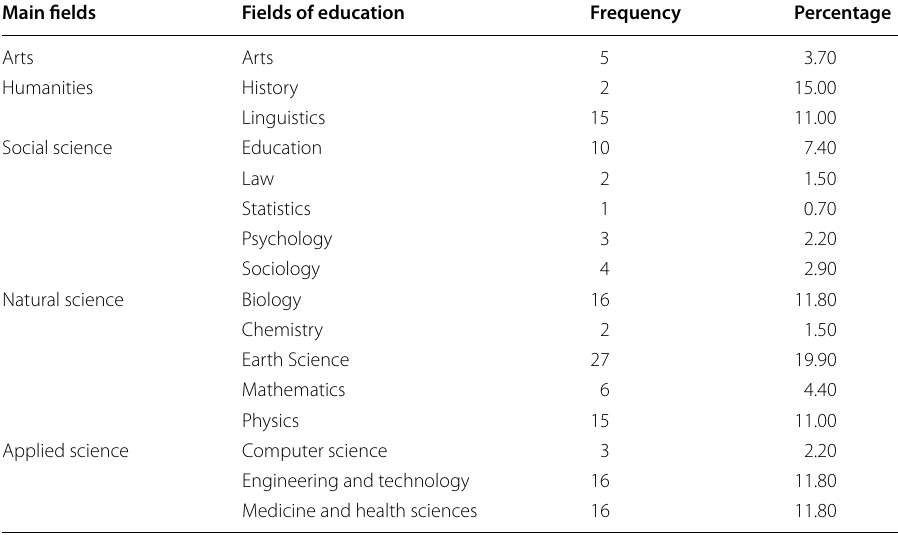
Table 8 Distribution of the studies based on fields of education Main